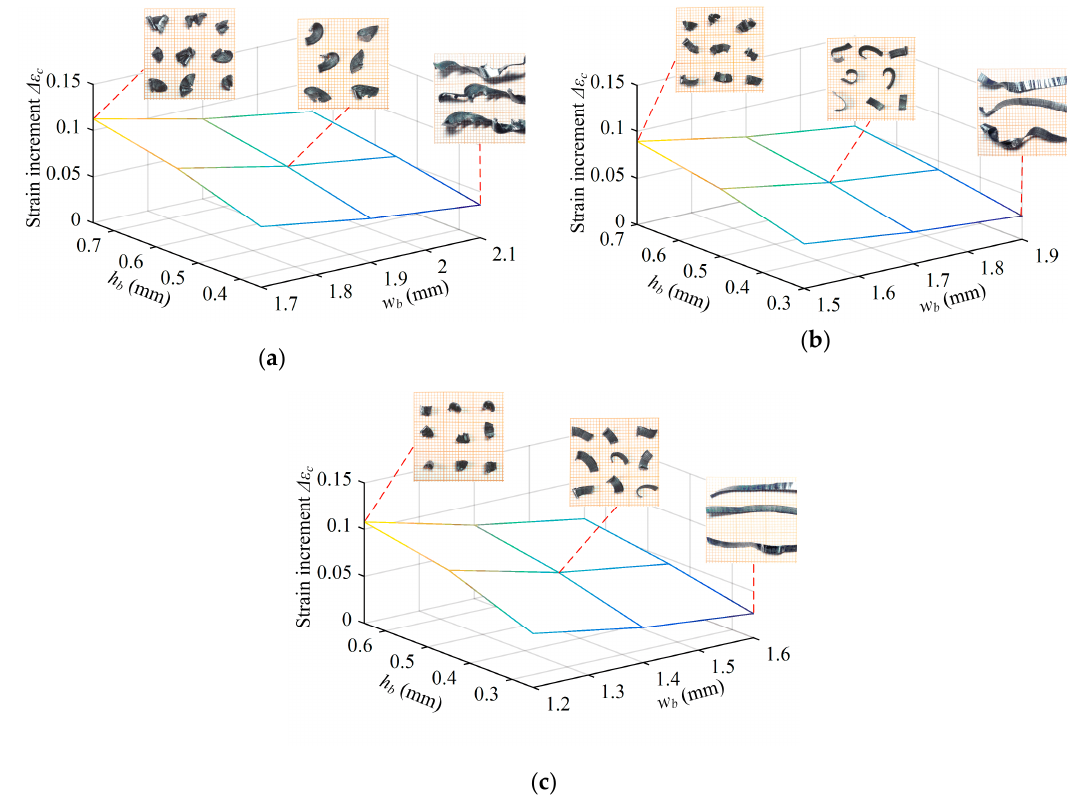
Figure 17. The tool-chip contact area of each tooth for staggered teeth BTA drill: ( a ) the central tooth, ( b ) the intermediate tooth, ( c ) the external tooth.